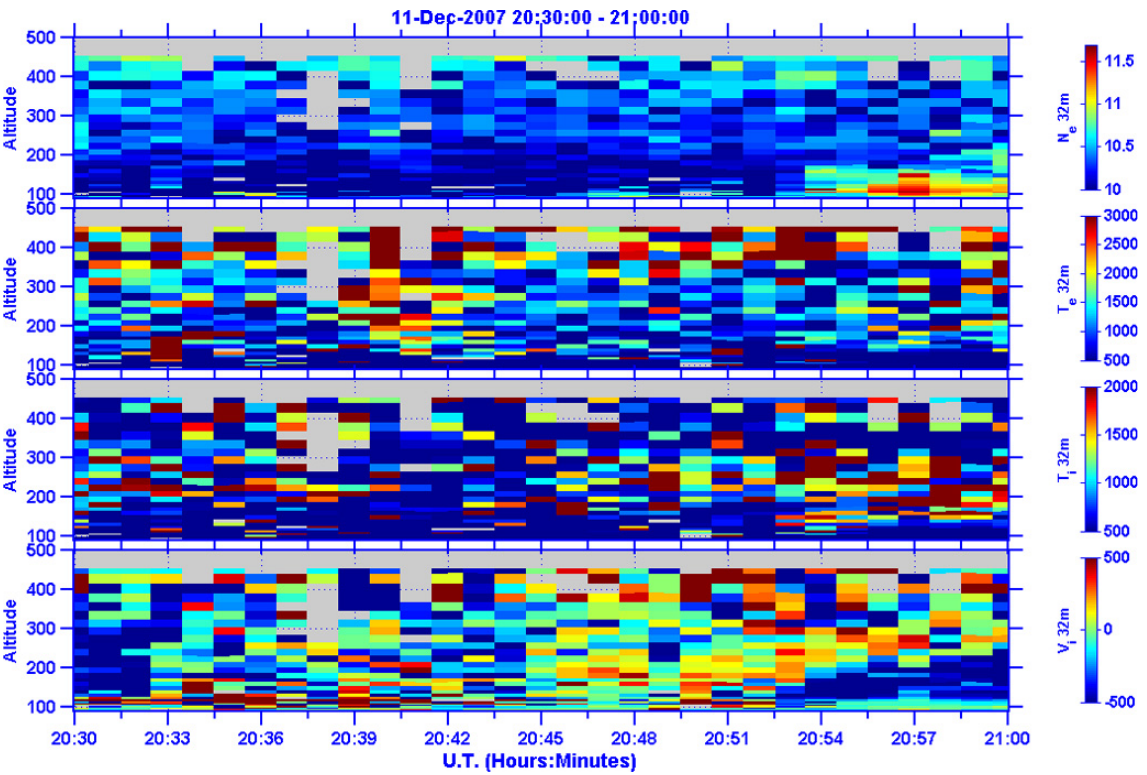
Fig. 7. ESR 32m dish – northward observations. Upper panel represents N e (log ( N e ) with N e in m − 3 ), second T e (K), third T i (K), and fourth V i (ms − 1 ). Altitudes are in km. All the ESR figures are built in the same way.